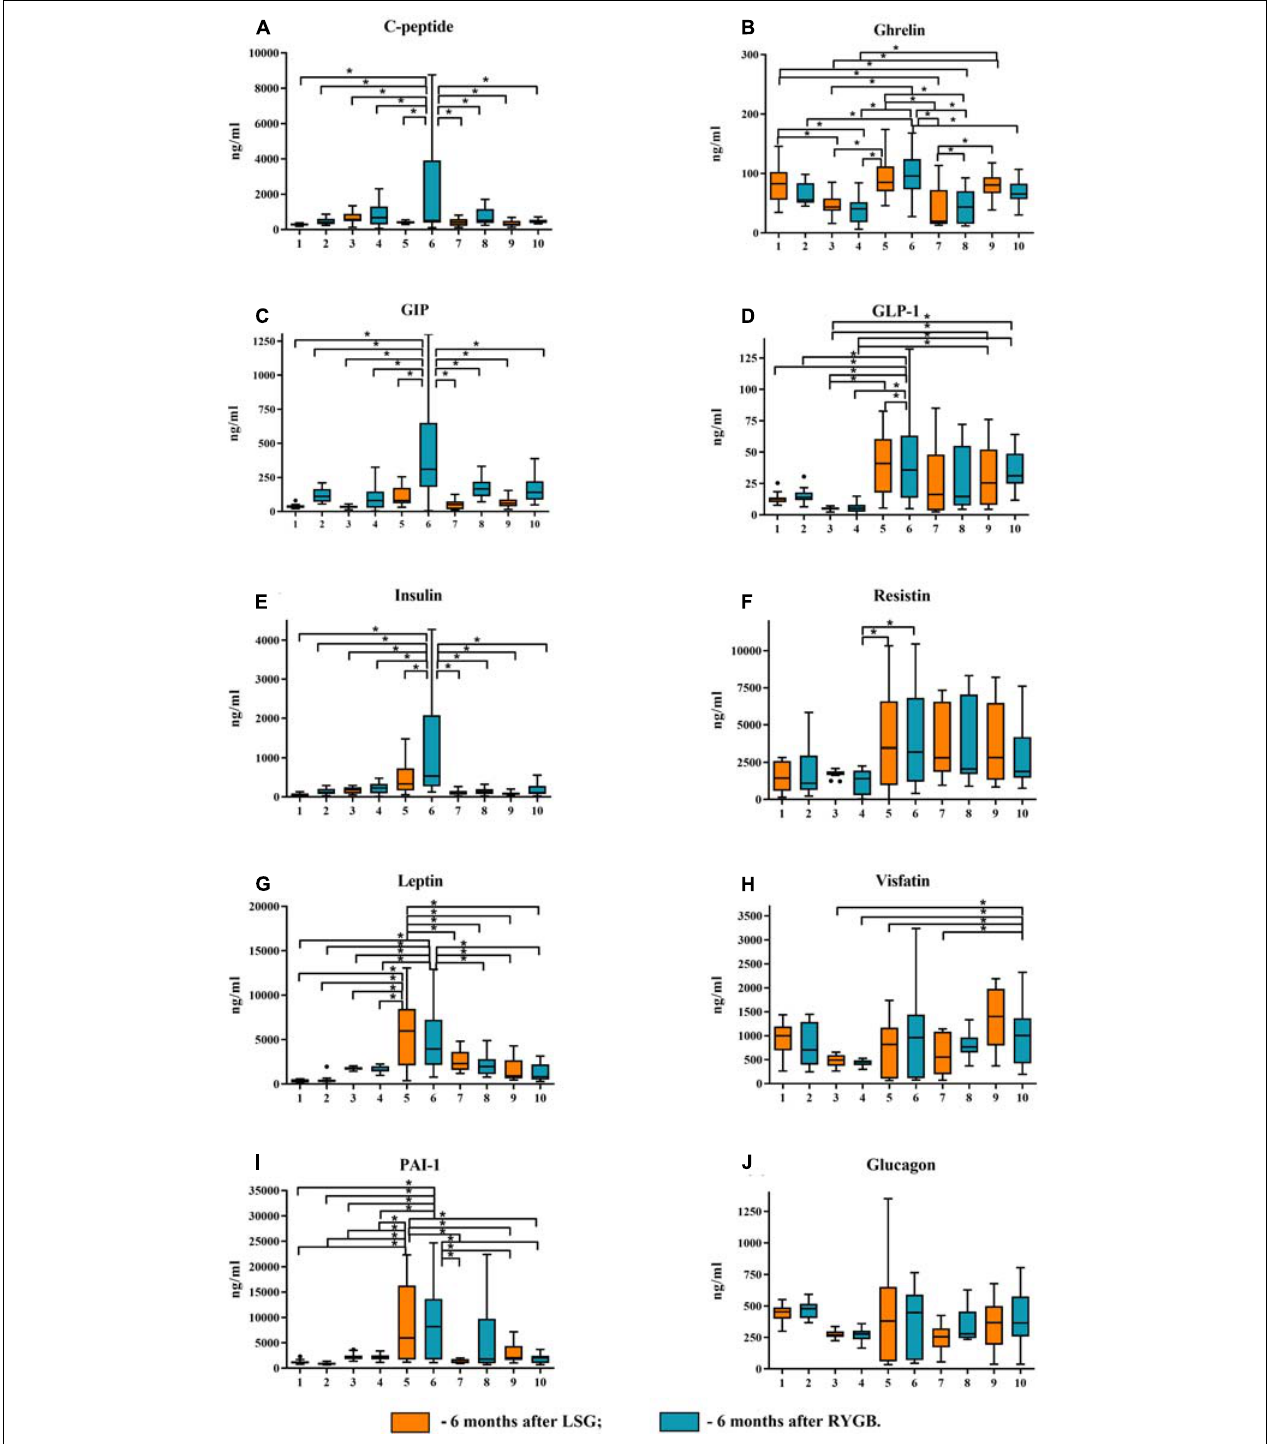
FIGURE 2 | Plasma levels of the studied mediators in obese patients with type 2 diabetes mellitus (T2DM) before and after laparoscopic sleeve gastrectomy (LSG) and Roux-en-Y gastric bypass (RYGB). (A) Plasma level of C-peptide. (B) Plasma level of ghrelin. (C) Plasma level of GIP. (D) Plasma level of GLP-1. (E) Plasma level of insulin. (F) Plasma level of resistin. (G) Plasma level of leptin. (H) Plasma level of visfatin. (I) Plasma level of PAI-1. (J) Plasma level of glucagon. ∗ p < 0.05; differences in significance level were determined using one-way ANOVA. 1 – healthy volunteers before breakfast; 2 – healthy volunteers after breakfast; 3 – obese patient without T2DM before breakfast; 4 – obese patient without T2DM after breakfast; 5 – obese patient with T2DM before breakfast; 6 – obese patient with T2DM after breakfast; 7 – 6 months after LSG before breakfast; 8 – 6 months after LSG after breakfast; 9 – 6 months after RYGB before breakfast; 10 – 6 months after RYGB after